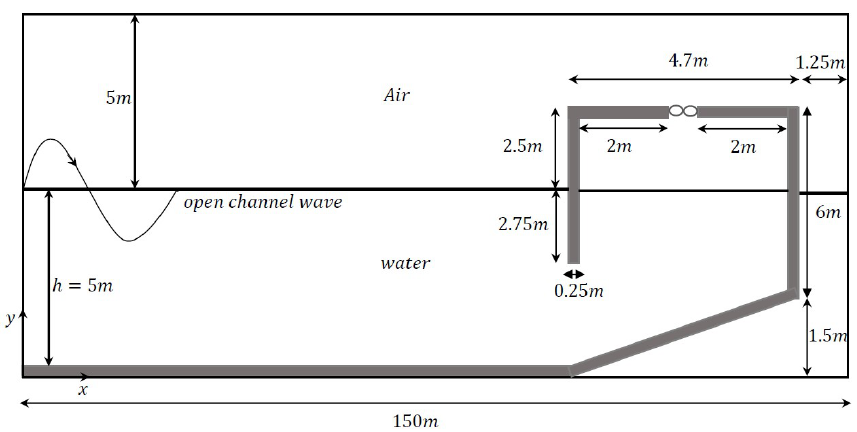
Figure 1. Vertical cross-section of the OWC device placed over the sloping